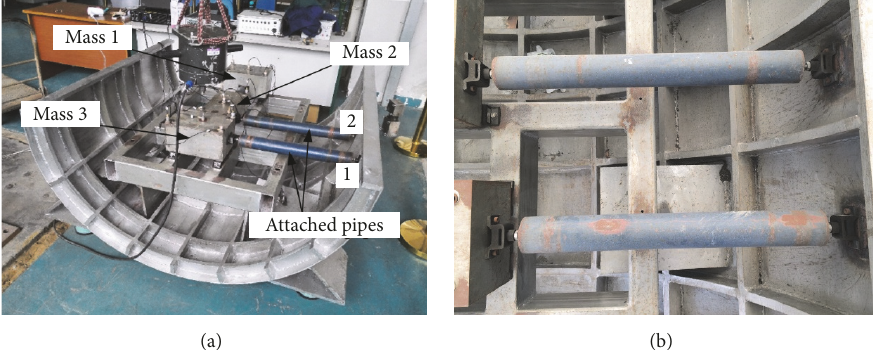
Figure 8: (a) FRF test setup of the floating raft system with attached pipes; (b) a close view of pipes and masses